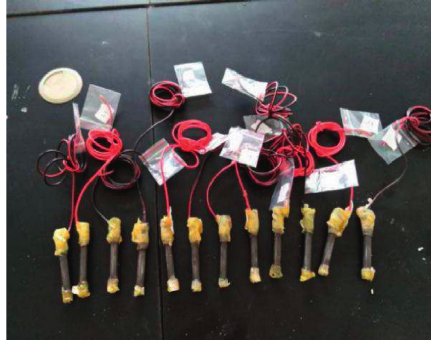
Figure 4: Steel bars after the anticorrosion